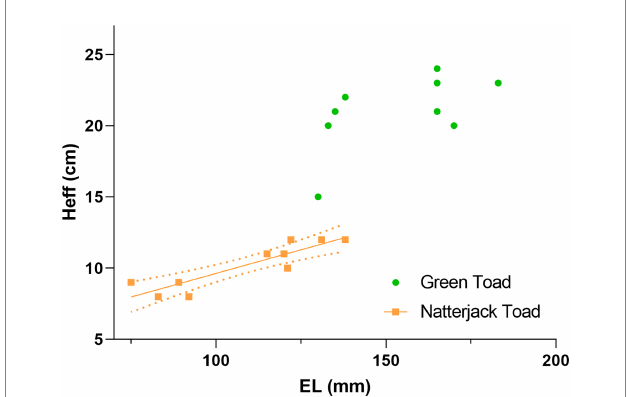
FIGURE 6 Relationship between elongation length (EL) and minimum effective fence height (H eff ) that prevented adult Natterjack and green toads from crossing the concrete fence without overhang (N = 10 for both species). Significant relationships are indicted by the solid line, with dotted lines indicating the 95% confidence bands. There was a significant positive relationship between parameters for Natterjack toads (for EL: p < 0.001, r 2 = 0.80), while this was not the case for green